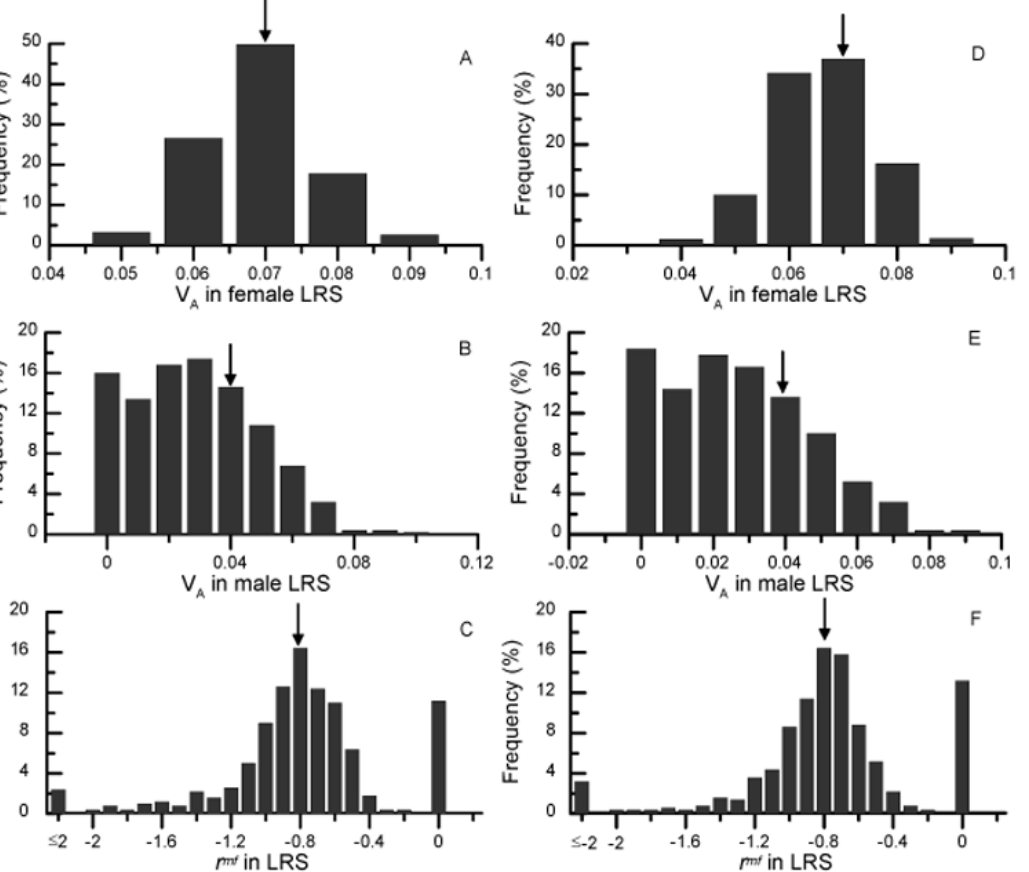
Figure 1. Simulations of results incorporating extra-pair paternities. Simulations either not assigned a random 15% of offspring (left panels, A–C) or directionally assigned them to a local male with a broader forehead patch (right panels, D–F). The frequency distributions of additive genetic variances in female LRS (A, D) and male LRS (B, E), and the intersexual genetic correlation in LRS (C, F) are based on 500 simulations. Correlations were left unconstrained and could therefore be lower than 2 1. The values based on the social pedigree (Table 2) are indicated with an arrow.